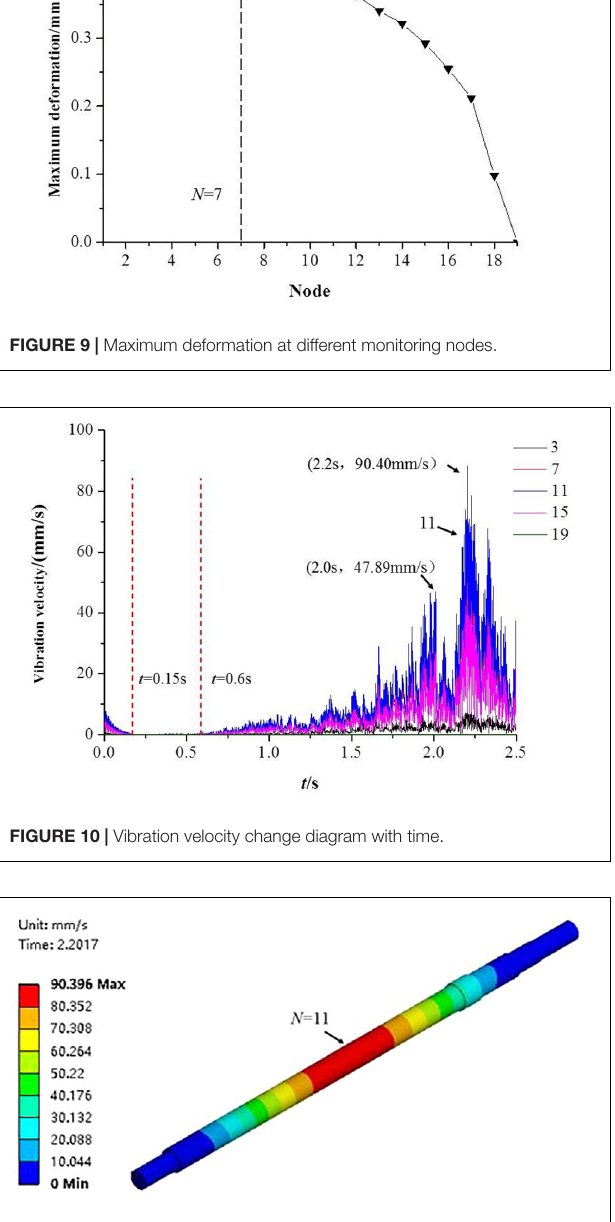
FIGURE 11 | Distribution of vibration velocity of pump shaft at t = 2.2